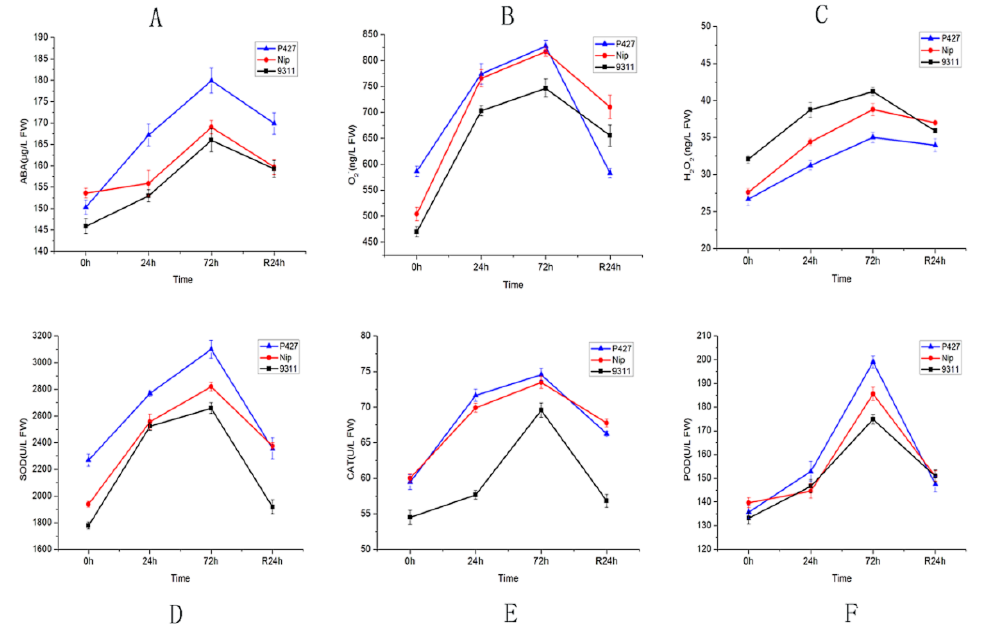
Figure 2. Physiological indices of the analyzed rice genotypes under chilling stress. ( A ) ABA content changes under chilling stress. ( B ) O 2 • − activity changes under chilling stress. ( C ) H 2 O 2 content changes under chilling stress. ( D ) SOD activity changes under chilling stress. ( E ) CAT activity changes under chilling stress. ( F ) POD activity changes under chilling stress.